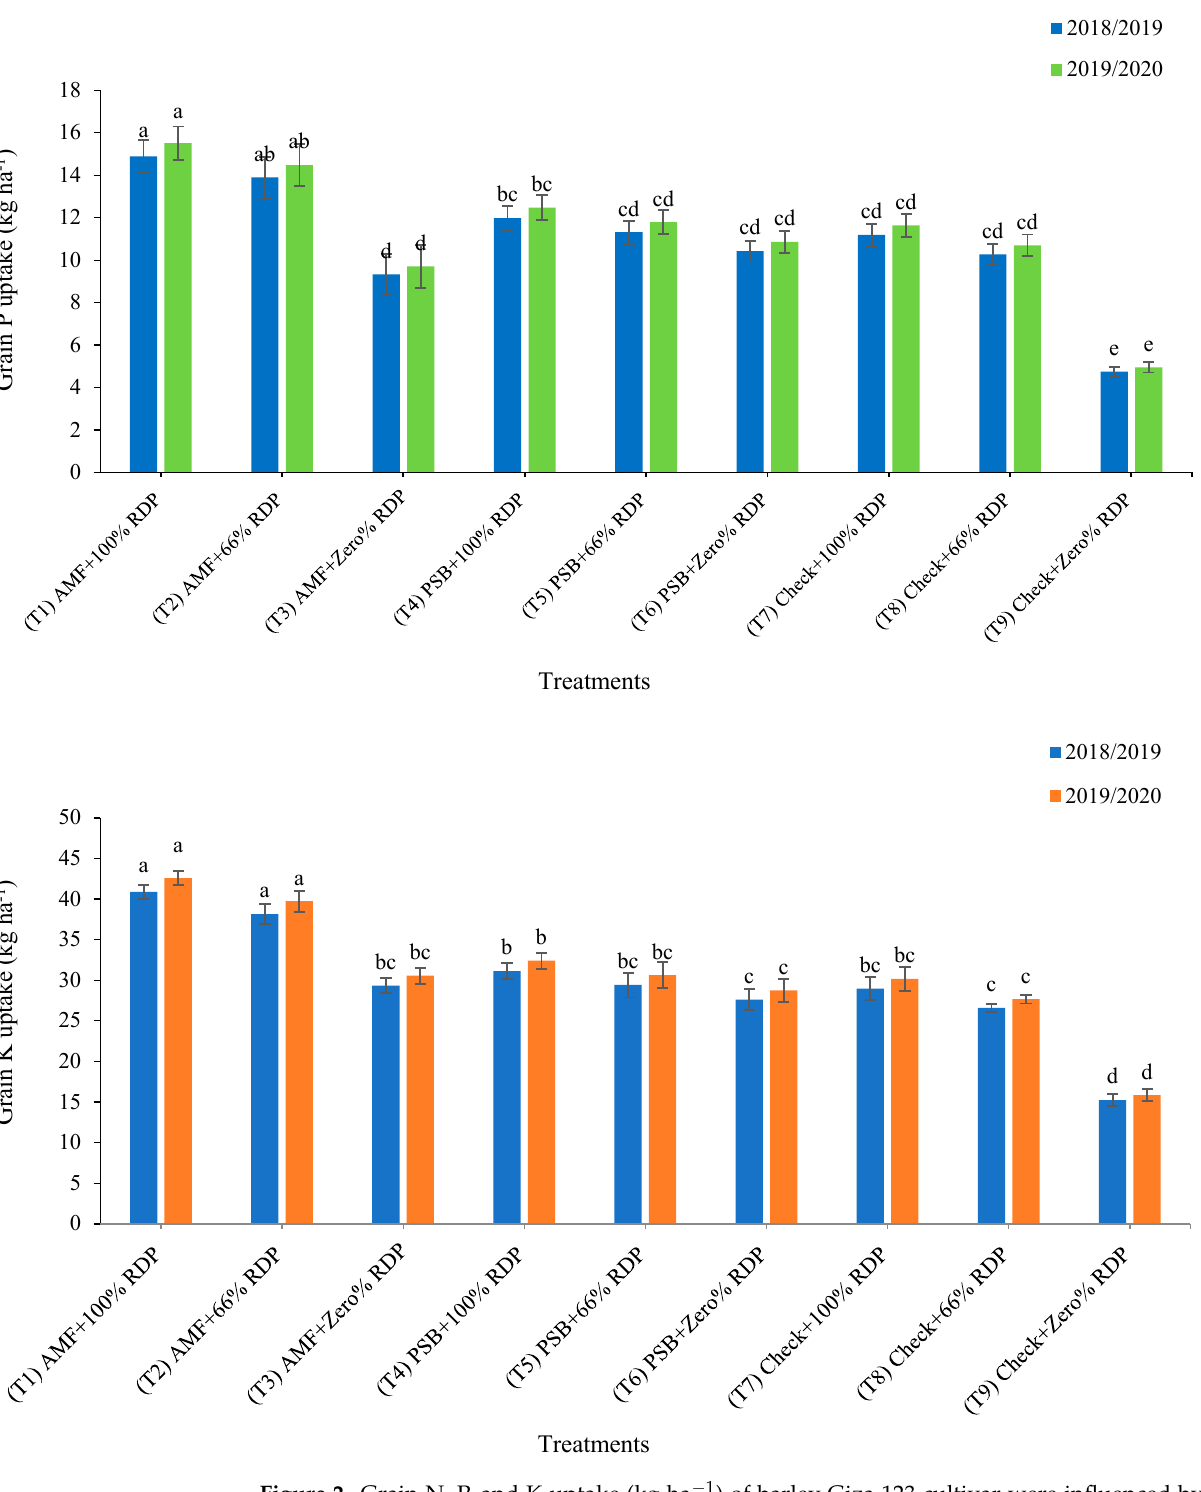
Figure 2. Grain N, P, and K uptake (kg ha − 1 ) of barley Giza 123 cultivar were influenced by the treatment of arbuscular mycorrhizal fungi (AMF), phosphate-solubilizing bacteria (PSB), and different percentages of the recommended dose of phosphorus fertilizers (RDP) in the 2018/2019 and 2019/2020 seasons. Different letters indicate significant differences at p ≤ 0.05 according to Duncan’s multiple range test.